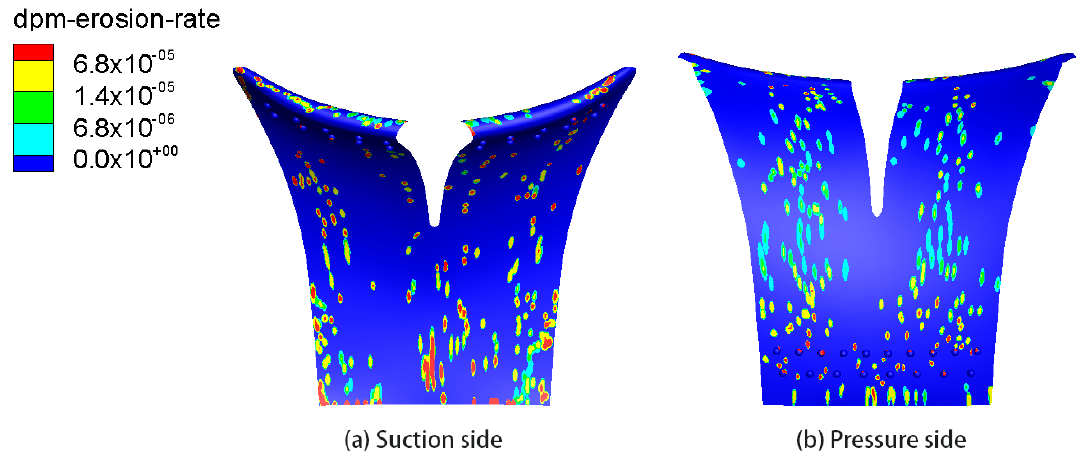
µ m/s, particle size: 0.04